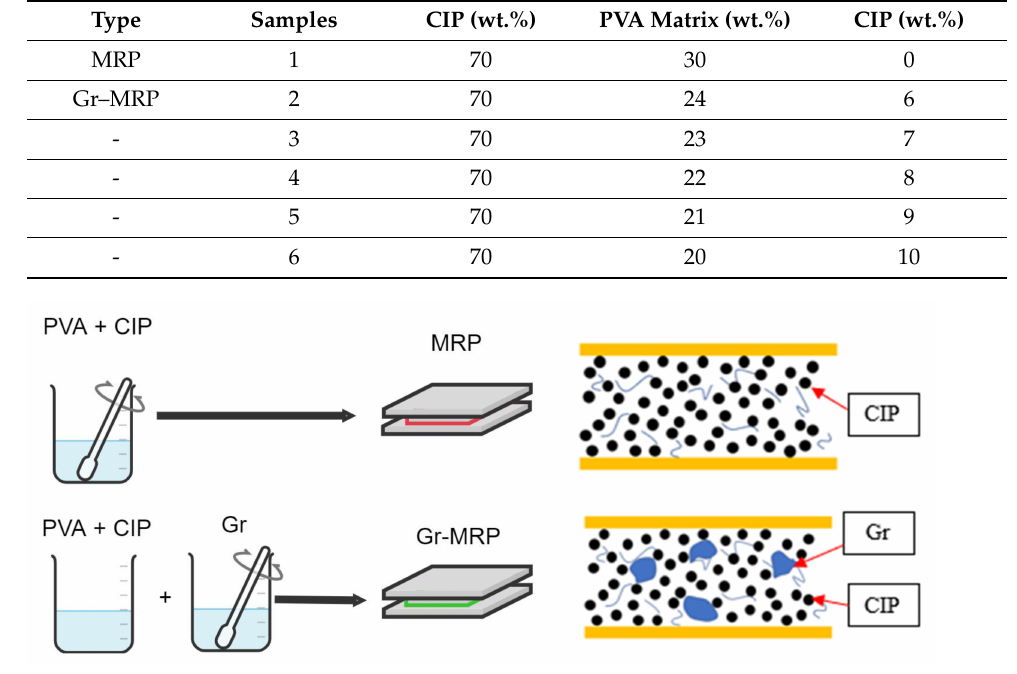
Figure 1. Fabrication process for MRP and Gr–MRP samples.